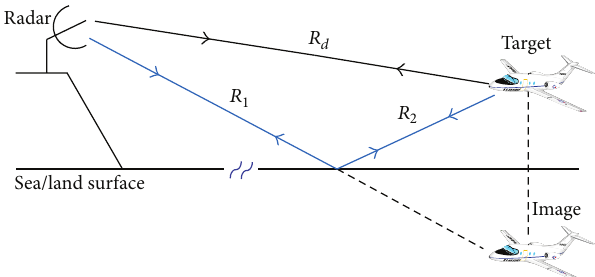
Figure 1: Representative scenario of multipath propagation in low grazing